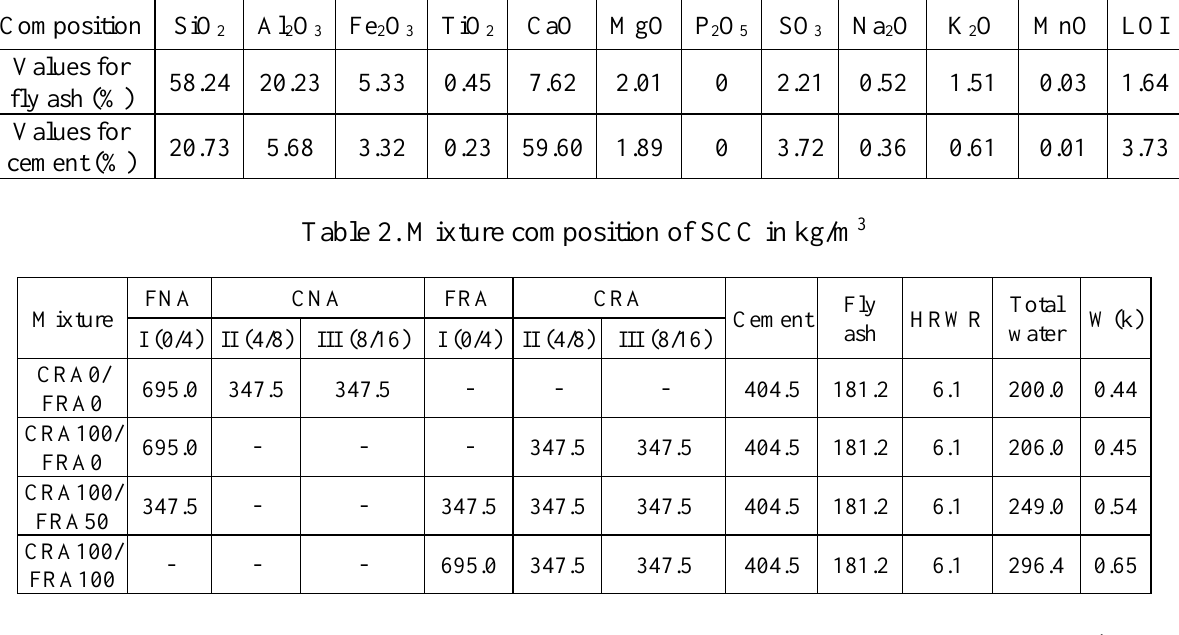
Table 1. Chemical composition of fly ash and cement